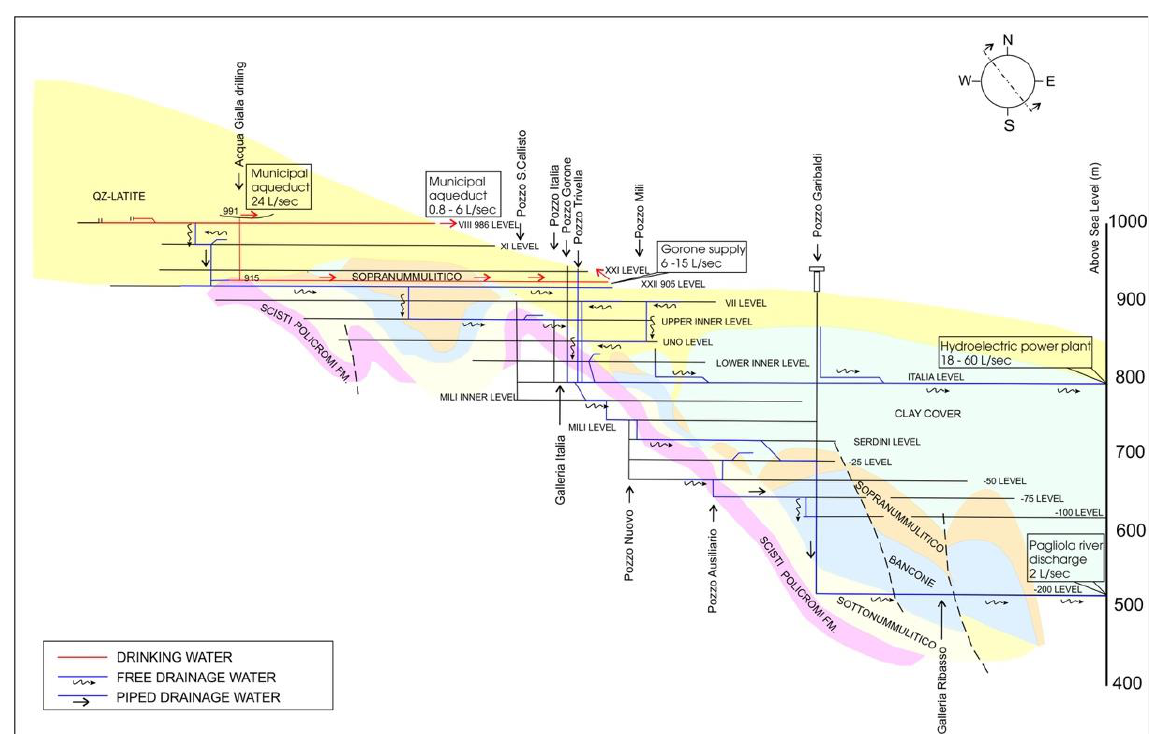
Figure 2. Schematic geological cross-section of the mining tunnels in the former mining site of Abbadia San Salvatore. For the sake of clarity, the local geological terms, such as scisti policromi (shales), sotto- and sopra-nummilitico (alternated calcarenites with grayish-greenish clays and grayish-pinkish calcarenites with grayish clays) and bancone (massive calcarenites) have been maintained (modified after [44]).